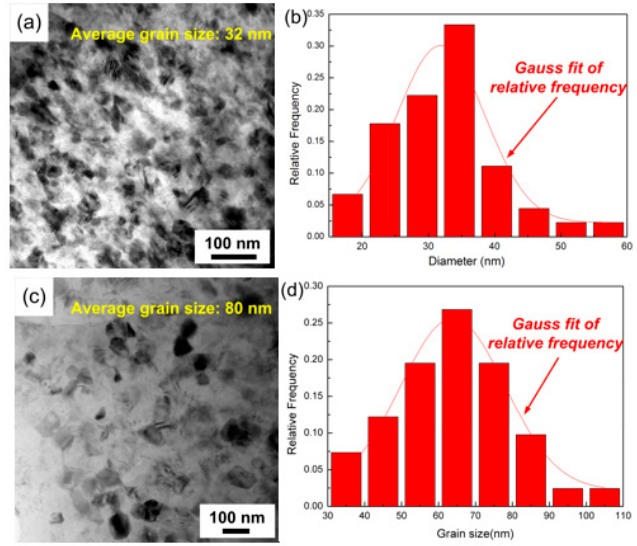
Figure 9. Transmission electron microscope (TEM) images and corresponding grain size distribution of milled SiCp/AZ91 ( a , b ) composite and AZ91 ( c , d )